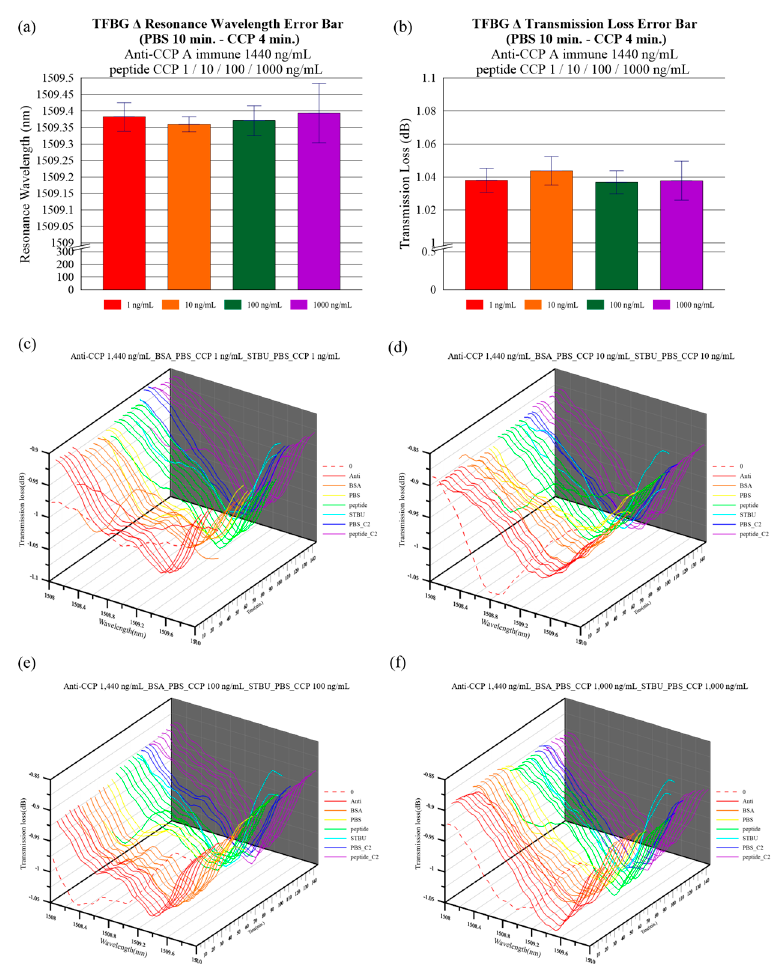
Figure 8. The mean variation and standard deviation in the ( a ) resonant wavelength shift and ( b ) transmission loss detected by the TFBG sensor after 10-min PBS immersion and 4-min CCP antigen immersion. ( c – f ) Measurement spectra for CCP antigen concentrations of 1 ng/mL, 10 ng/mL, 100 ng/mL, and 1000 ng/mL, respectively.